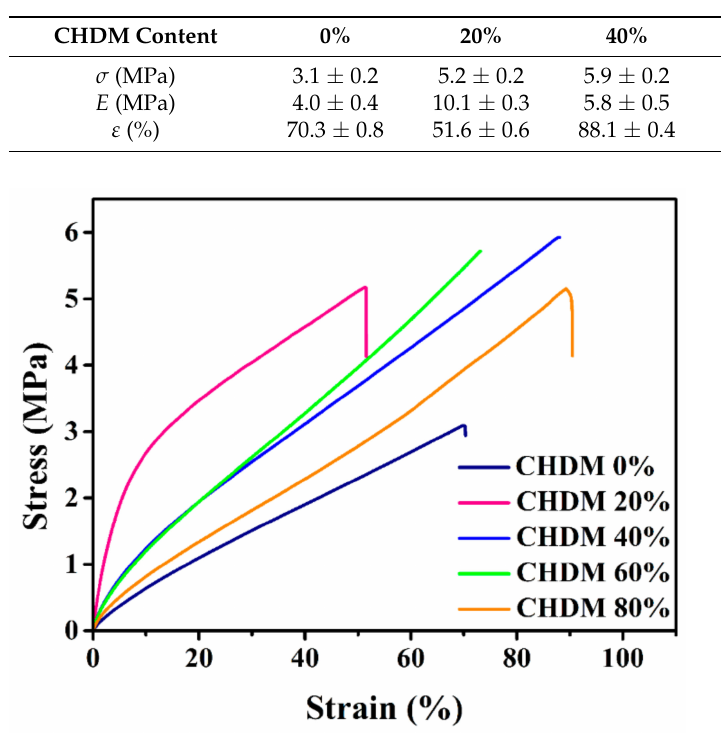
Figure 8. Stress-strain profiles of cross-linked